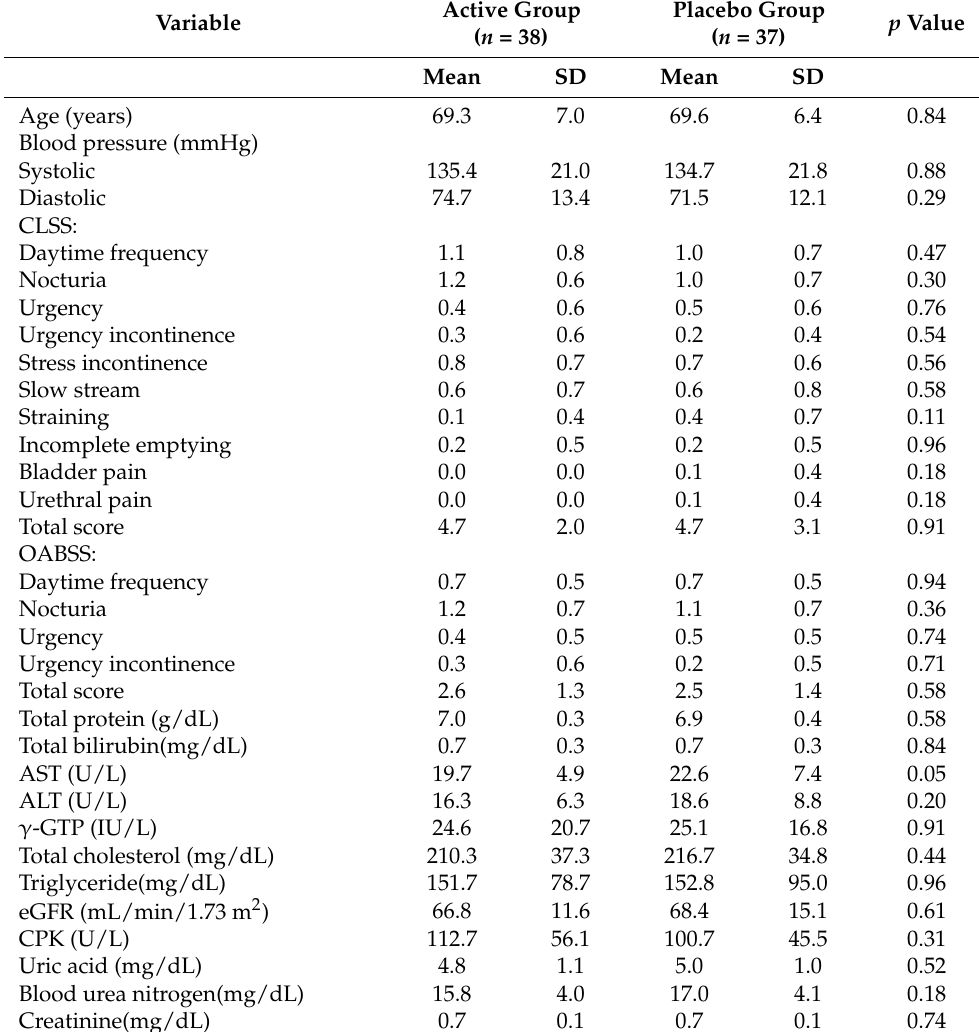
Table 1. Subject backgrounds in SPE treatment (active) and placebo